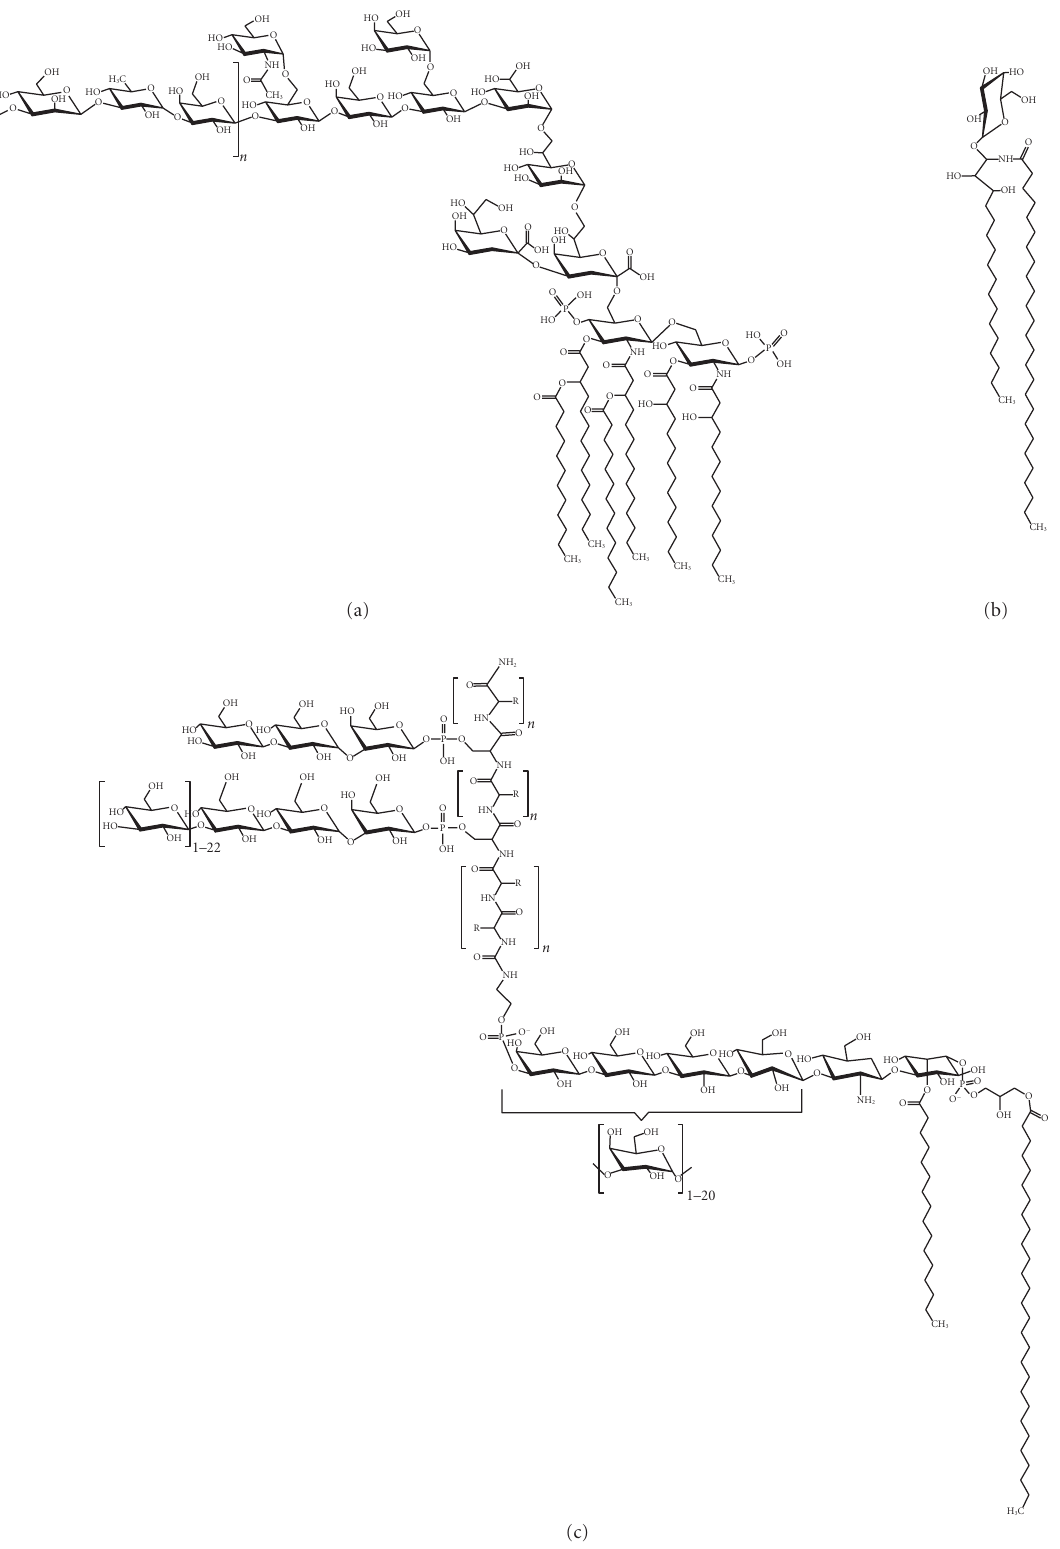
Figure 1: (a) Lipopolysaccharide (LPS) from the Gram-negative bacterium Escherichia coli is the most potent activator of TLR4 [54]. (b) Alpha-galactosyl ceramide from the marine sponge Agelas mauritanius is presented via CD1d and activates NKT cells [55]. (c) Partial structure of lipopeptidophosphoglycan (LPPG) from Entamoeba histolytica of the HM1:IMSS strain, which was originally isolated from a patient with liver abscess [56, 57]. The structure of the active phosphoinositol moiety of LPPG was characterized in